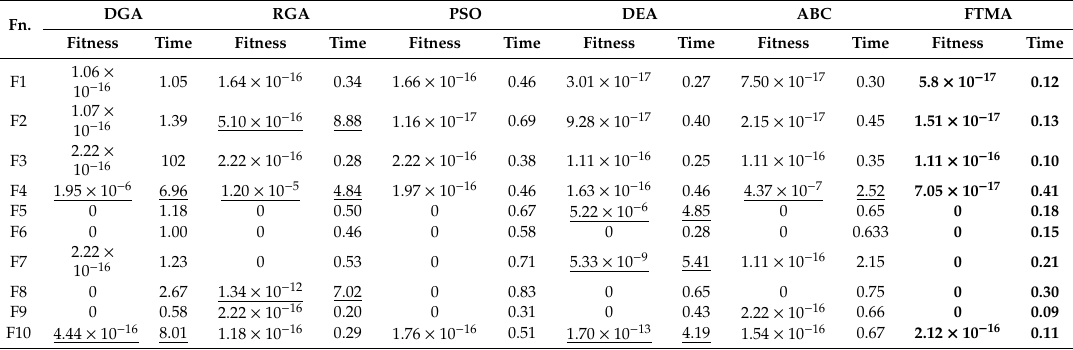
Table 3. Results of the global fitness and computation time (s) for a sample trial. DGA: Genetic algorithm (decimal form); RGA: Genetic algorithm (real form); PSO: Particle swarm optimization; DEA: Differential evolution algorithms; ABC: Artificial bee colony; FTMA: fine-tuning meta-heuristic algorithm.